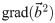
(a) is a schematic illustration of the positional relationship between the cylindrical vessel and the solenoidal superconducting magnet coil. In the bore of the magnet, the vertical component of magnetic force is symmetrical about the coil center (see bold arrows). The magnitude of grad(b→2) becomes largest around the representative points of Pover and Punder, and its direction is oriented to the vertical. Consequently, the effect of gravity can be most efficiently controlled by the magnetic force. (b) the representative points a–i marked on the vertical cross-section of the cylindrical vessel.